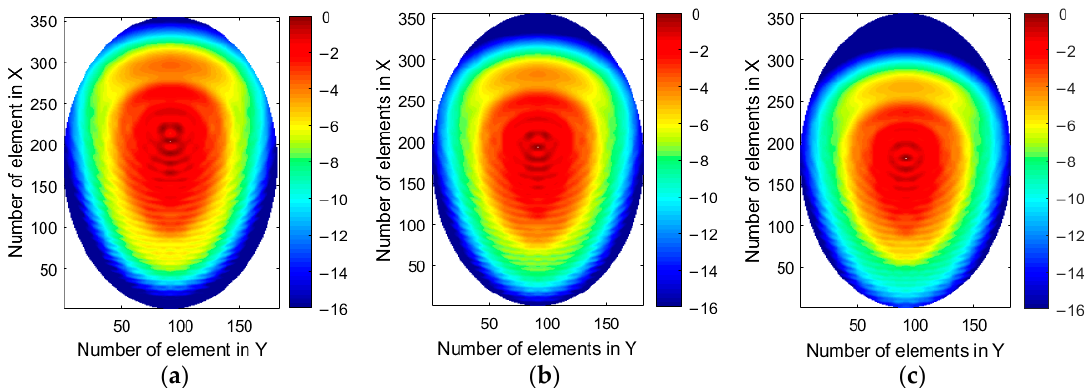
Figure 8. Amplitude (in dB) of the incident field on the main RA when the antenna is illuminated from: ( a ) F 1 , ( b ) F 3 and ( c ) F 5 .